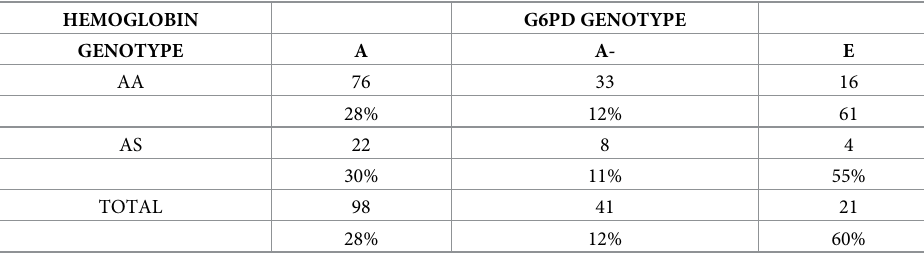
Table 2. Prevalence and assortment of hemoglobin genotype (HbAA and HbAS) and G6PD genotypes.